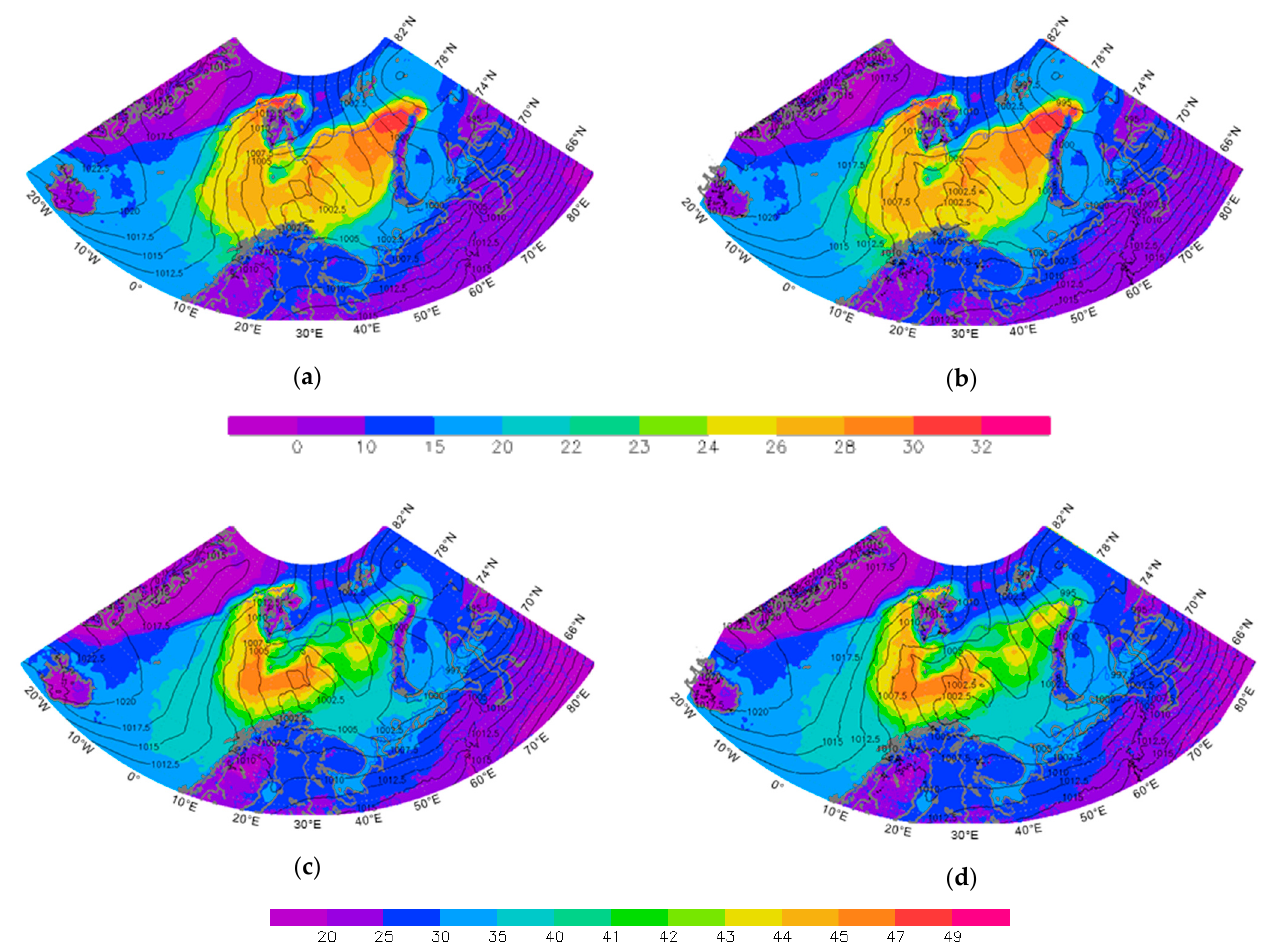
Figure A3. ICON ‐ A6.5 (left) and ICON ‐ A2 (right): difference between sea surface temperature and temperature on isobaric surfaces 700 hPa ( a , b ), 500 hPa ( c , d ) at 04:00 UTC 26 November 2019.